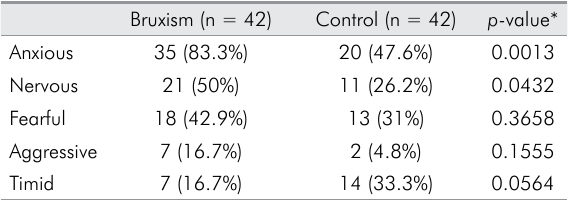
Table 1. Relative frequency (n.%) of psychological factors as observed by parents/guardians.